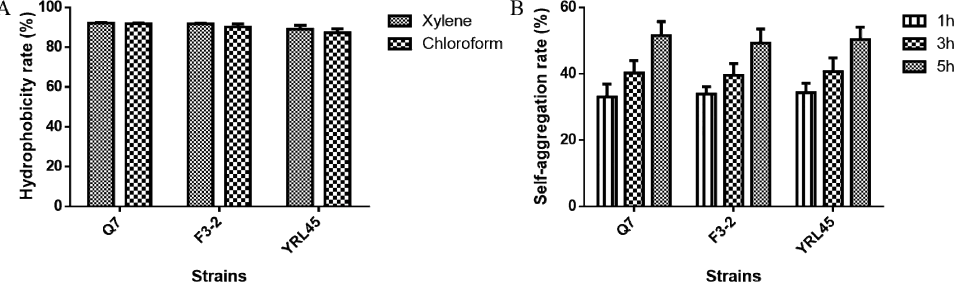
Figure 3. Hydrophobicity ( A ) and self-aggregation ( B ) of L. plantarum Q7, L. plantarum F3-2 and L. plantarum YRL45.